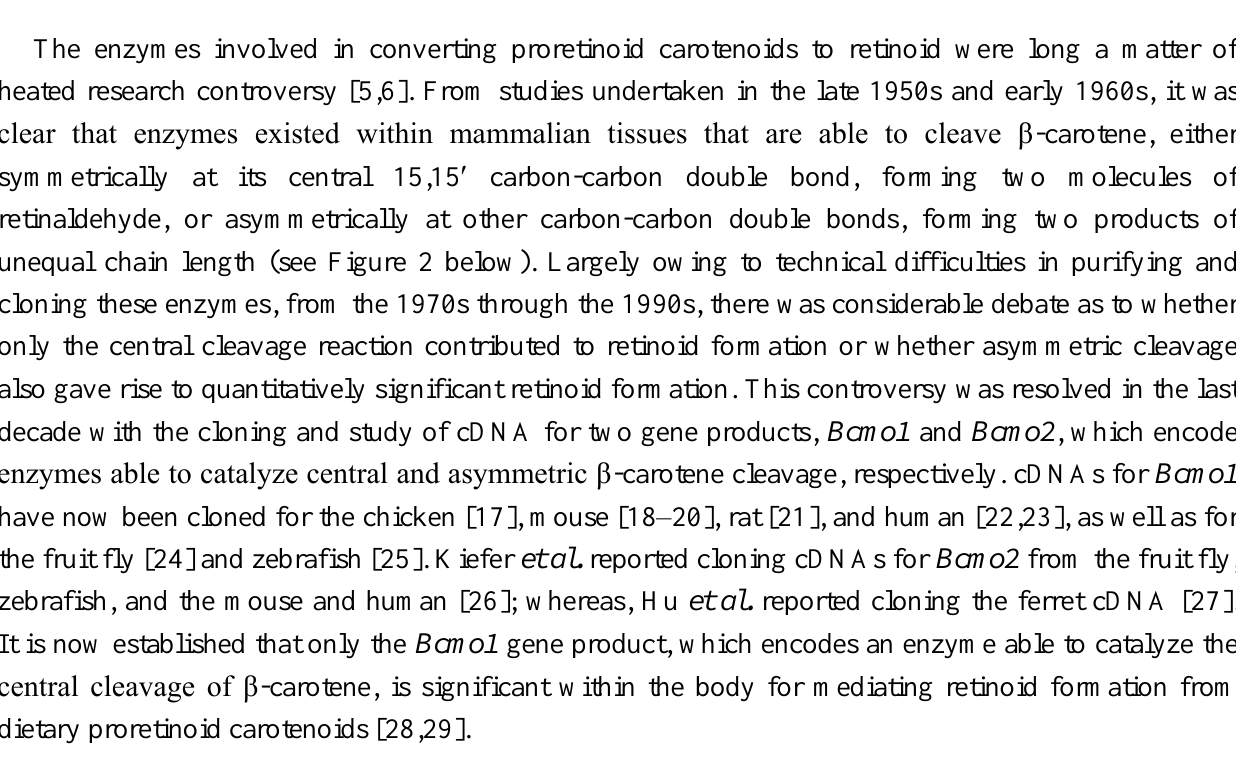
Figure 2. Carotenoids can undergo cleavage either symmetrically by BCMO1 or asymmetrically by BCMO2. Beta-Carotene